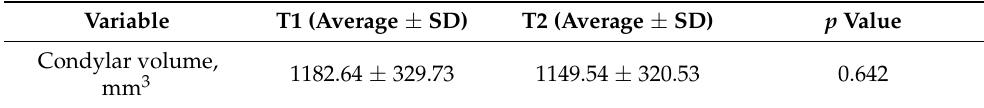
Figure 9. Group comparison using shape analysis—vector maps pre-treatment (T1) and post- treatment (T2); ( A ), anterior view; ( B ), posterior view; ( C ), lateral view; ( D ), medial view; ( E ), superior view. Table 4. Volume changes between T1 and